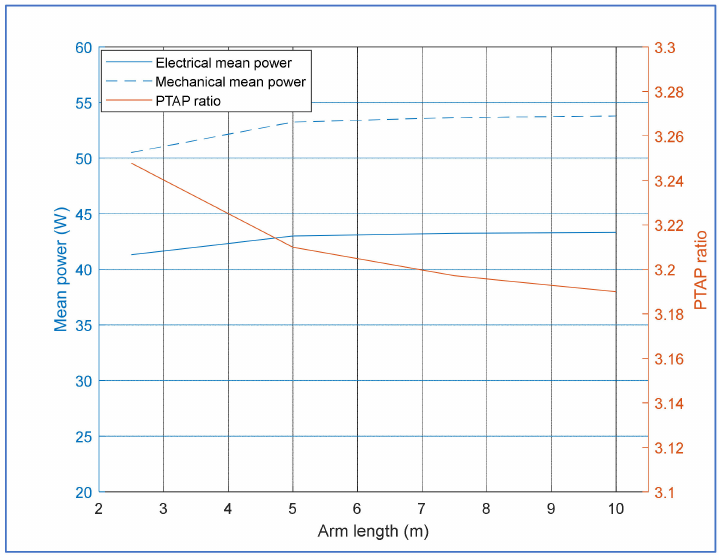
Figure 14. Variation of electrical and mechanical mean power, and PTAP ratio with crank radius at r = 1.5